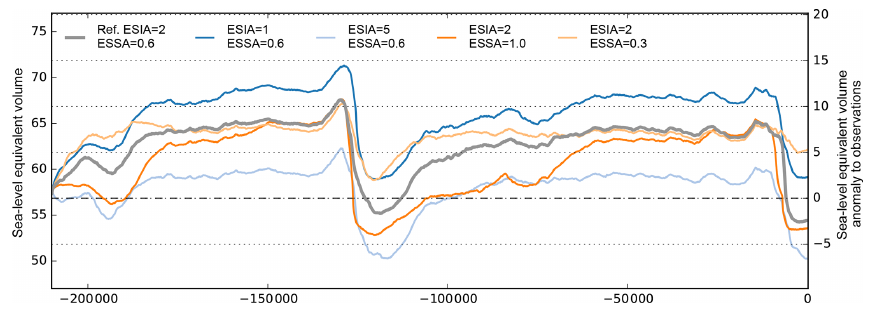
Figure 3. Ice volume above flotation for simulations over the last two glacial cycles, with varied enhancement factors for SIA and SSA stress balance. Lower E SIA values lead to thicker grounded ice sheets, while larger E SSA values cause faster deglaciation and slightly thinner modern ice sheets.